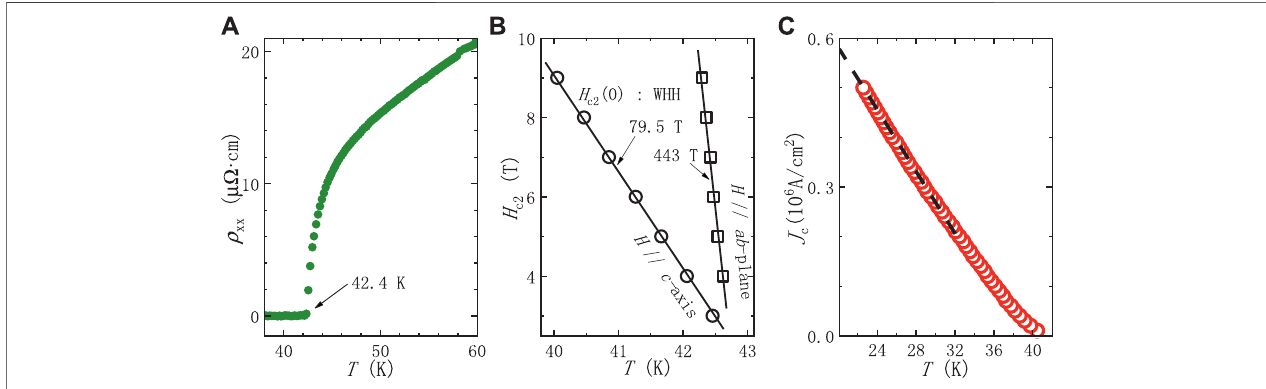
FIGURE 10 | High superconducting critical parameters for (Li,Fe)OHFeSe fi lm. (A) Temperature dependence of in-plane resistivity, with the onset ofzero resistivity at 42.4 K. (B) Temperature dependence of H c2 alongthe c -axis (circle) and within the ab plane (square). (C) The temperature dependence of J c , exceeding0.5 MA/cm 2 at 20 K